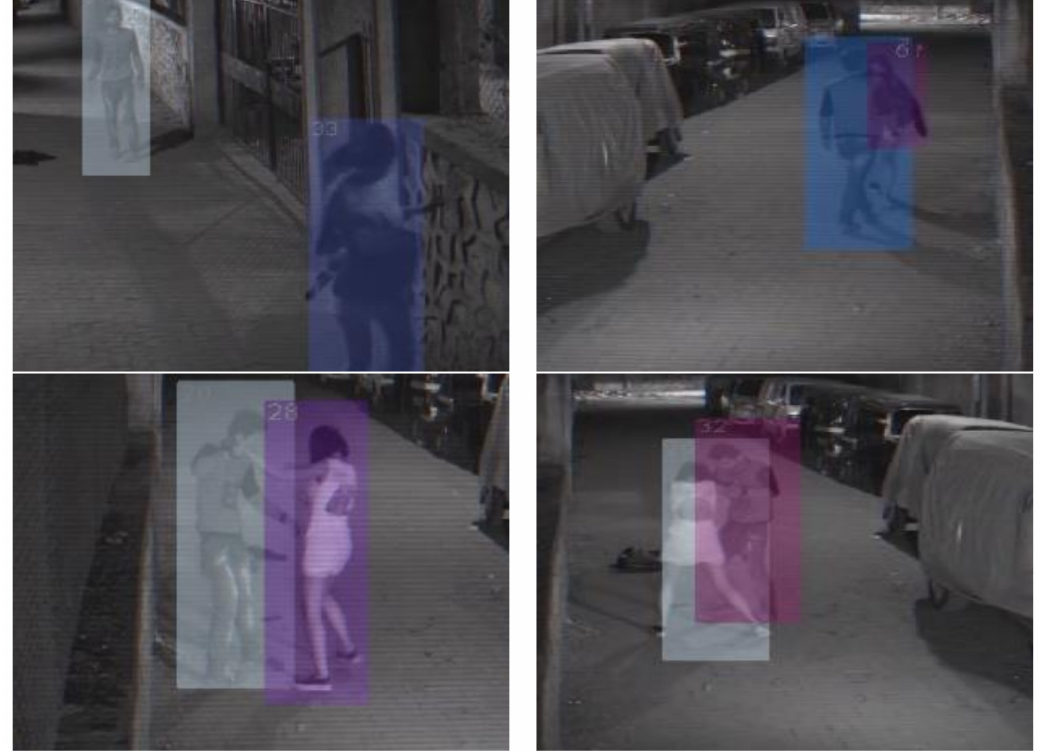
Figure 4. Multiple object tracking and extraction of the regions of interest (ROIs) or tracks. In these images, pedestrians are detected, and an identification number is assigned to each